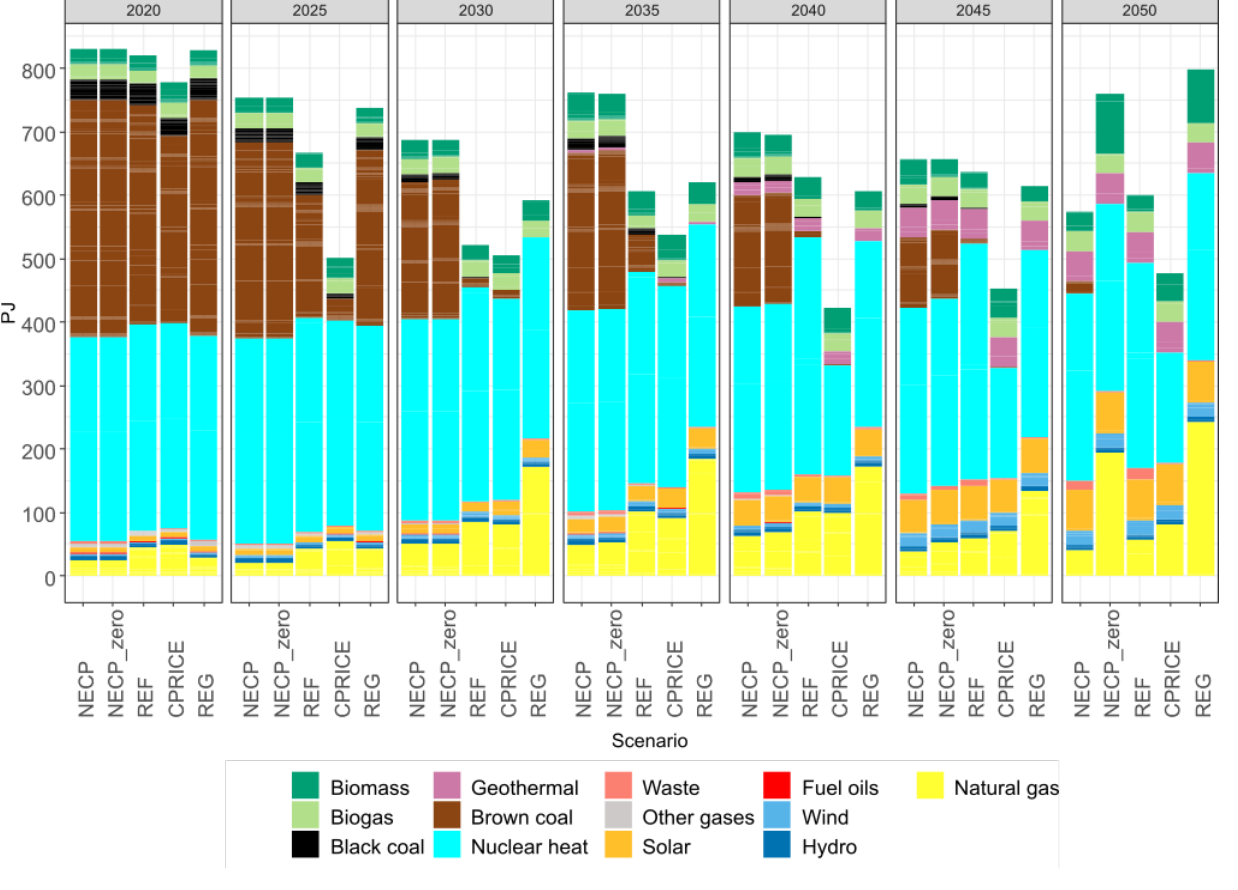
Figure 2. Energy input for heat and power generation. Table 6. Cumulative new installations of electricity generation capacities (GWe).